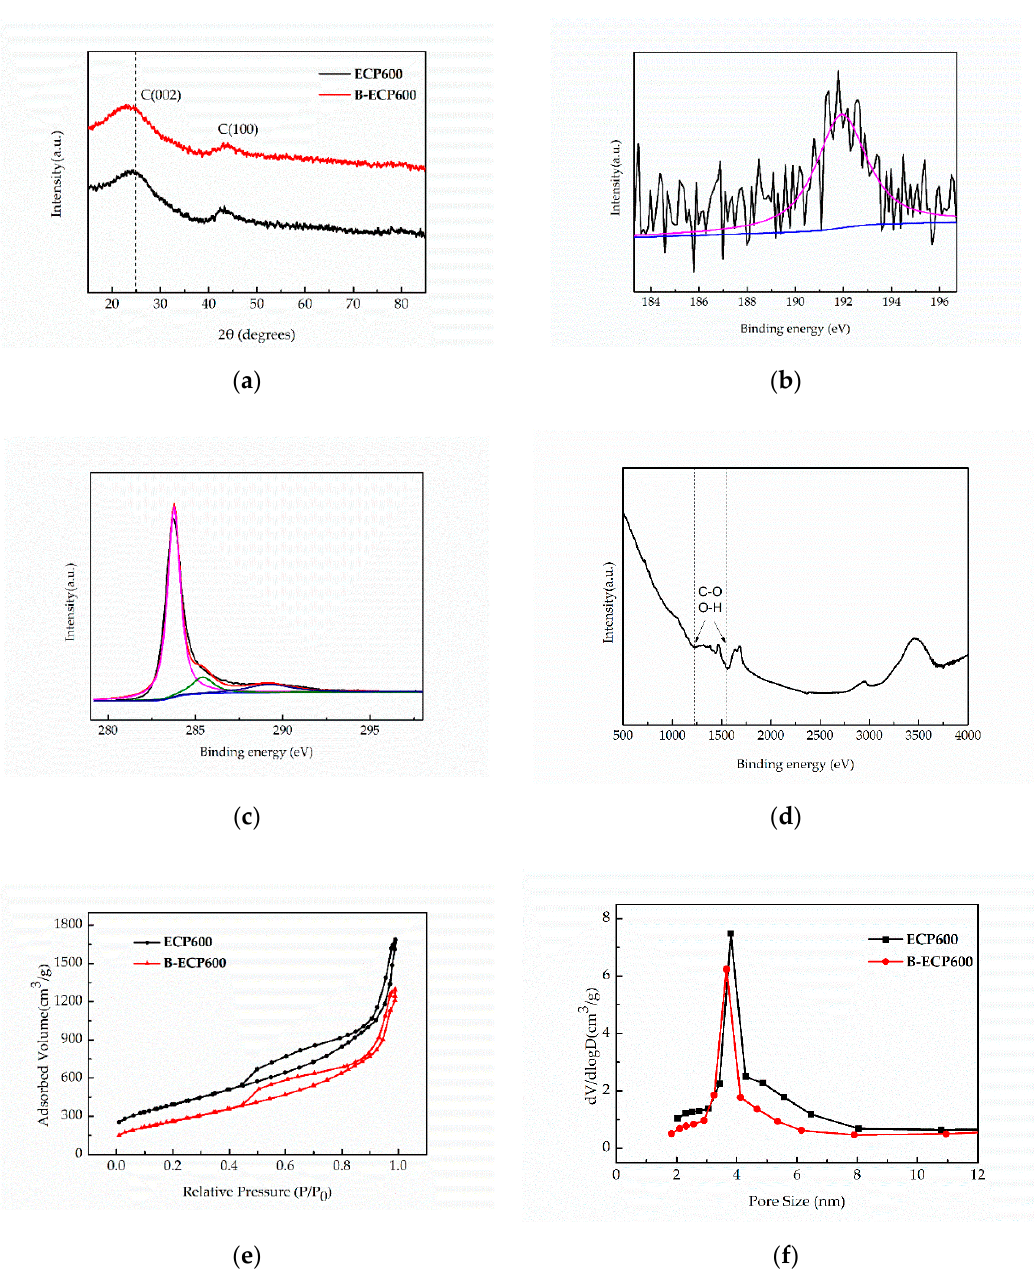
Figure 1. ( a ) XRD results of ECP600 and B-ECP600; ( b ) B1s; ( c ) C1s narrow-scan of B-ECP600; ( d ) FTIR spectrum of B-ECP600; ( e ) nitrogen adsorption–desorption isotherms; and ( f ) pore size distributions of ECP600 and B-ECP600.